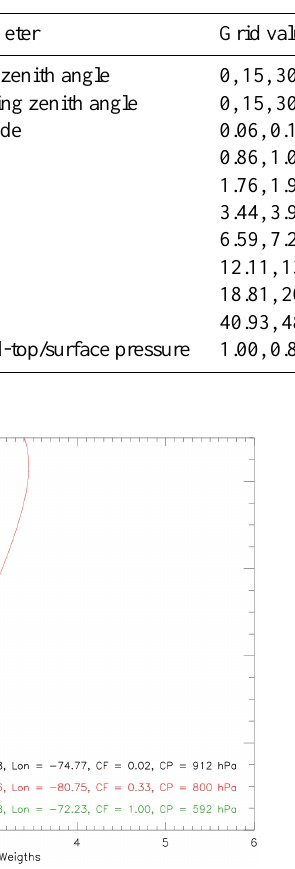
Table 2. Parameters of the weighting function look-up table.